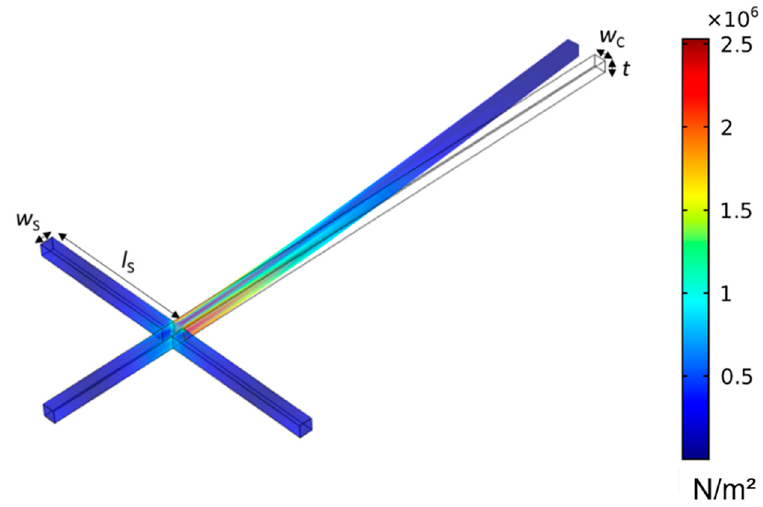
Figure 4. Cantilever deflection by FEM upon in-plane excitation with the generated von Mises stress marked by coloring. Table 1. Material parameters of FEM in COMSOL